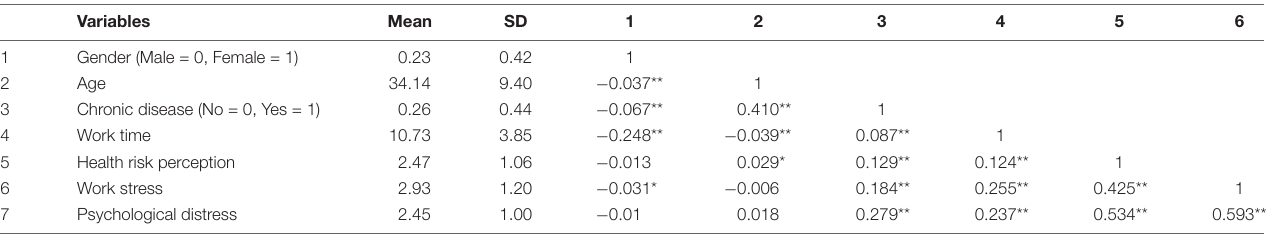
TABLE 6 | Descriptive statistics and correlations.